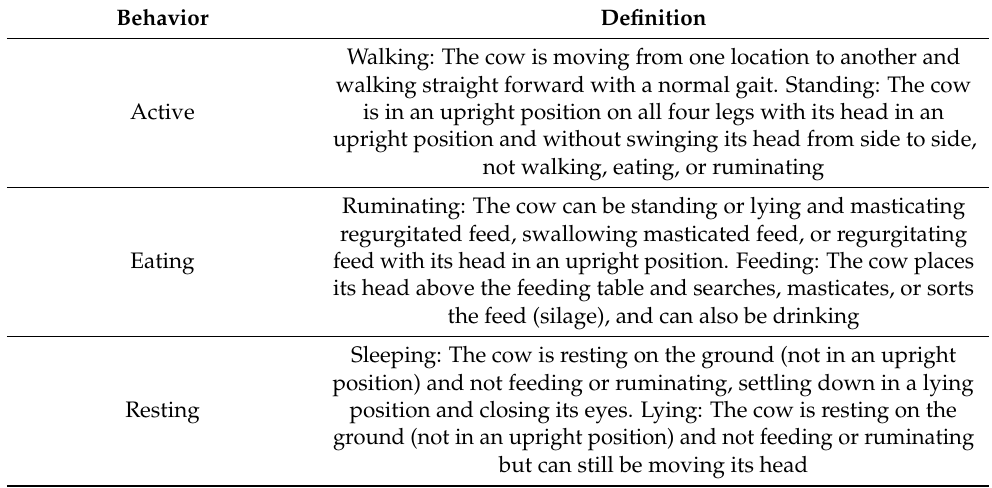
Table 1. Classification and description of the different behavior categories for actual